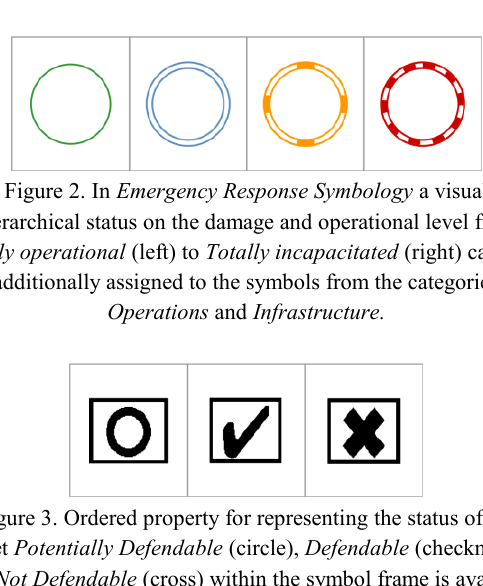
Figure 1. Incidents (diamond), Operations (circle) and Infrastructure (rectangle) are used for thematic and visual organisation of cartographic symbols in Emergency Response Symbology, Canadian All-Hazards Symbology and Australian All Hazard Symbology . Category Observations (pentagon) is added in new version of the Australian All Hazard Symbology.